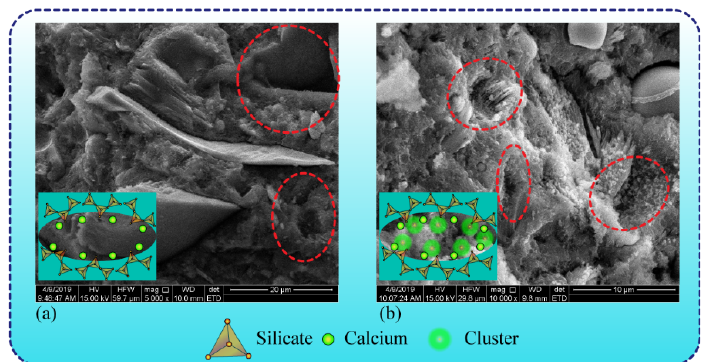
Figure 12. SEM micrograph of cement pastes ( a ) without and ( b ) with TIA after 28 days of hydration time.